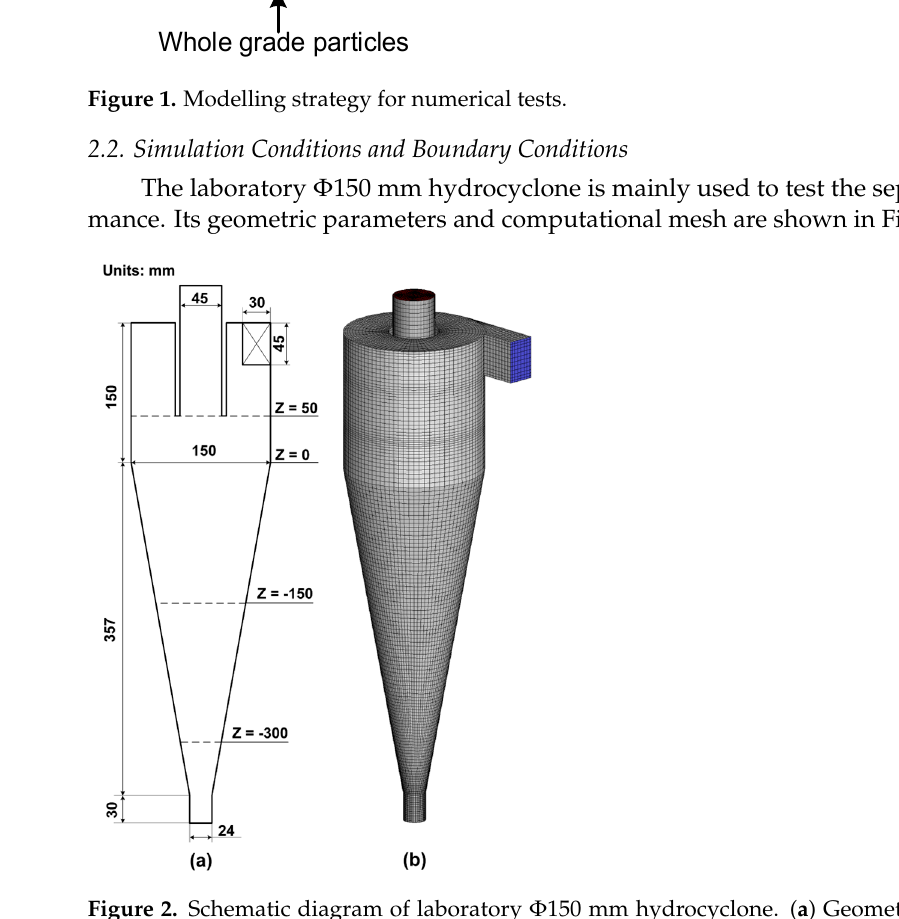
Figure 2. Schematic diagram of laboratory Φ 150 mm hydrocyclone. ( a ) Geometrical parameters; ( b ) Computational mesh.